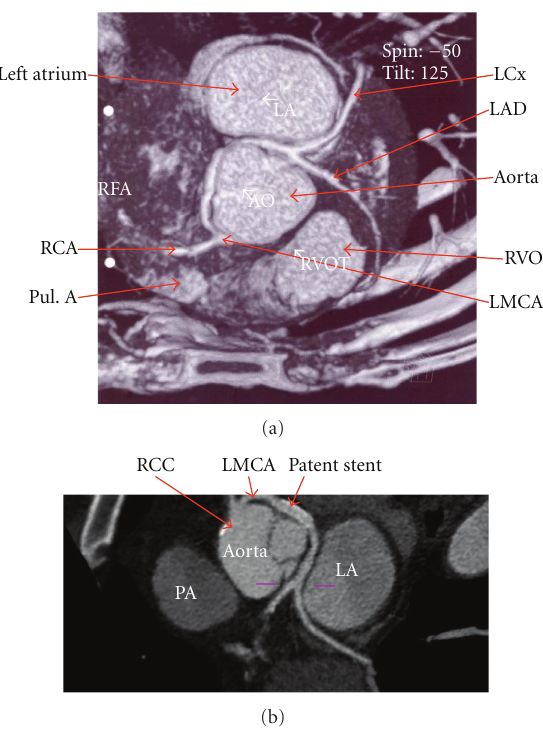
Figure 1: Computerized tomography angiogram. (a) Shows ano- malous left main coronary artery (LMCA) arising from the single right coronary cusp and then has the retroaortic course (present- ing). Main stem shows significant discrete stenosis. (b) Demon- strates patent stent in anomalous LMCA (after stenting).